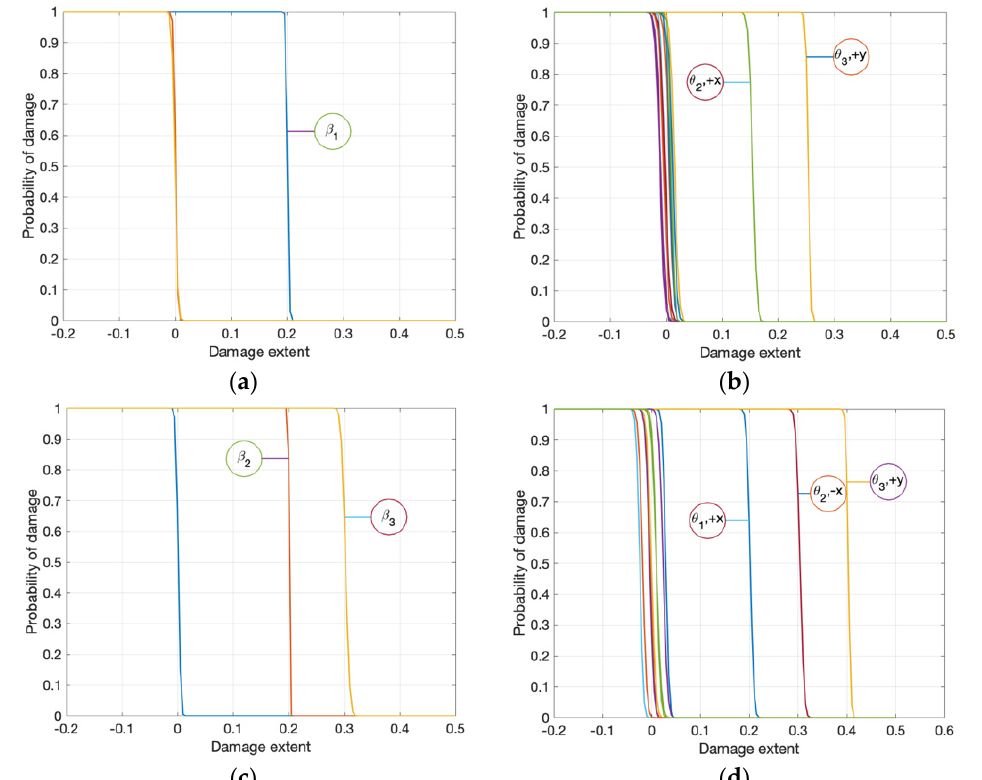
Figure 11. Probabilistic curves. Damage case No. 1: ( a ) mass; ( b ) stiffness. No. 2: ( c ) mass; ( d ) stiffness.